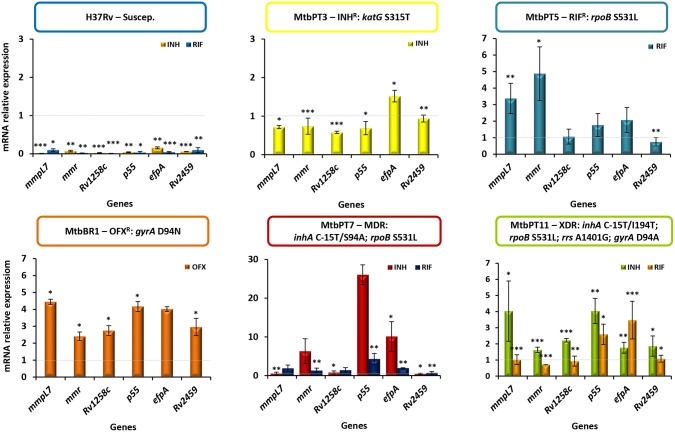
Quantification of the relative mRNA expression levels of a panel of efflux pump genes. Strains were grown in MGIT tubes for the MGIT 960 system in the presence of half MIC of each antibiotic as follows: MtbPT3 was exposed to isoniazid; MtbPT5 was exposed to rifampicin; MtbBR1 was exposed to ofloxacin; H37Rv, MtbPT7, and MtbPT11 were exposed to isoniazid or rifampicin. The relative expression of the efflux pump genes was assessed by comparison of the relative quantity of the respective mRNA in the presence of an antibiotic to the non-exposed strain. A level of relative expression equal to 1 indicates that the expression level was identical to the strain that was being compared (gray dashed line in the graphs). Genes showing expression levels above 1 were considered to be expressed; genes showing expression levels above two were considered to be significant overexpressed. The results were considered significant when *P < 0.05; and highly significant when **P < 0.01 and ***P < 0.001.